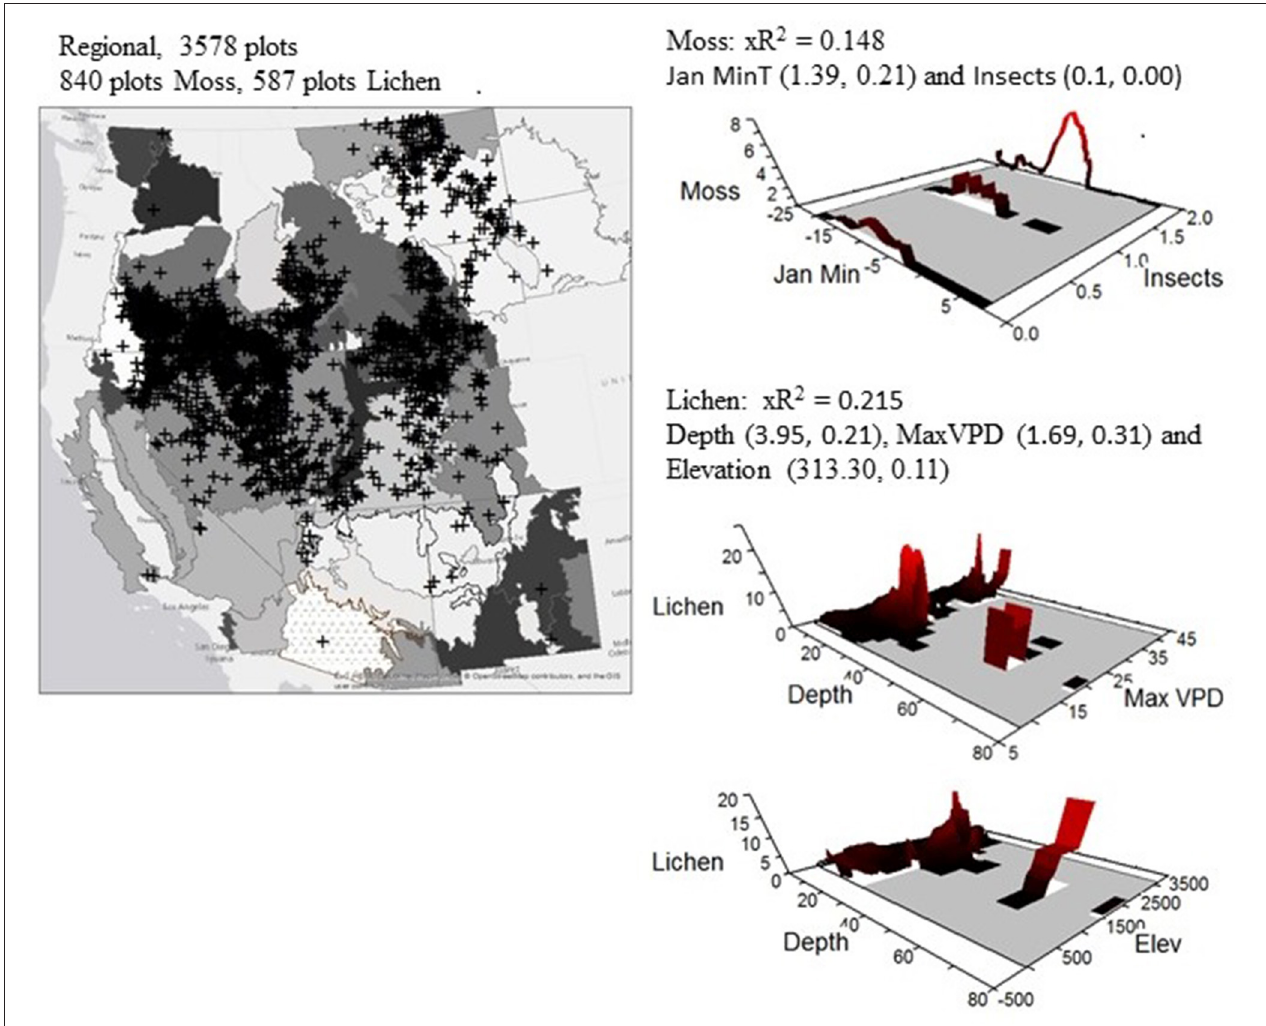
FIGURE 2 | The geographical distribution of the total number of plots classified in each identified plant community and the number of plots that were recorded as having mosses and lichens. The background is the EPA Level 3 ecoregions. Adjacent to the map are NPMR models that of the best regional predictors of lichen cover: maximum vapor pressure deficit (Max VPD), soil depth (Depth) and Elevation and for moss cover: January minimum temperature (JanMinT) and Insects. For each model the cross-validated R 2 (xR 2 ), tolerance, and sensitivity are